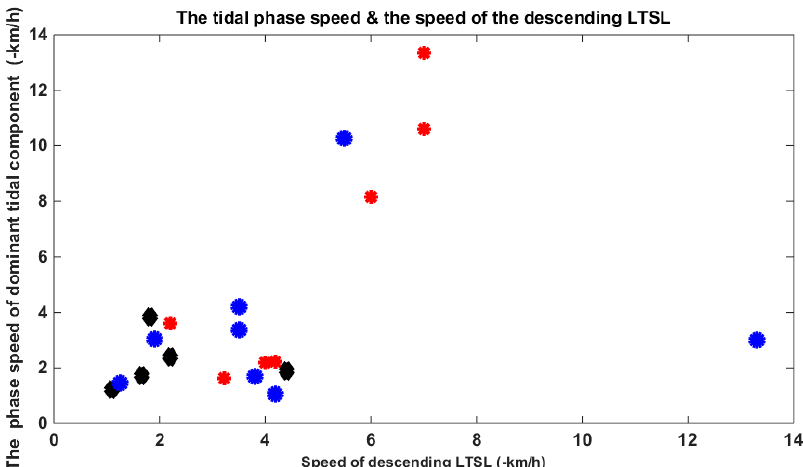
Figure 9. The tidal phase speed versus the speed of the descending LTSL (“ − km/h”: negative means downward).